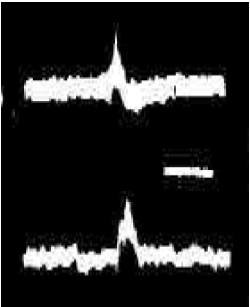
Figure 3. Oscillogram photographed in 1963 at Columbia University, Department of Neurology, showing the first ever example of a spontaneous polyneuronal barrage of field and action potentials (top trace) driving a stereotyped burst of muscle twitches. Recorded in an organotypic culture derived from a presumptive brainstem motor region of the frog neural plate. Time bar = 1